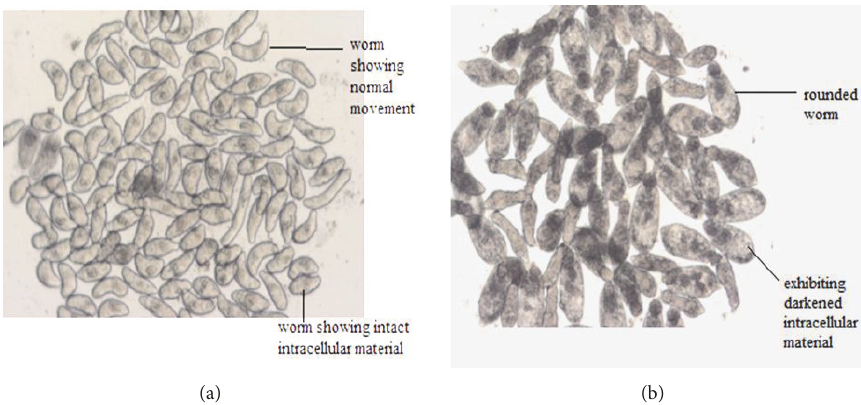
Figure 3: Examples of somules after exposure to E. ivorense extract fractions. (a) Control somules after 24 h. Each somule is approximately 200 𝜇 m in length. (b) Somules exposed to 2.5 𝜇 g/mL of the acetone fraction of the methanol leaf extract after 24 h. Note the rounding and severe degeneracy relative to control worms.